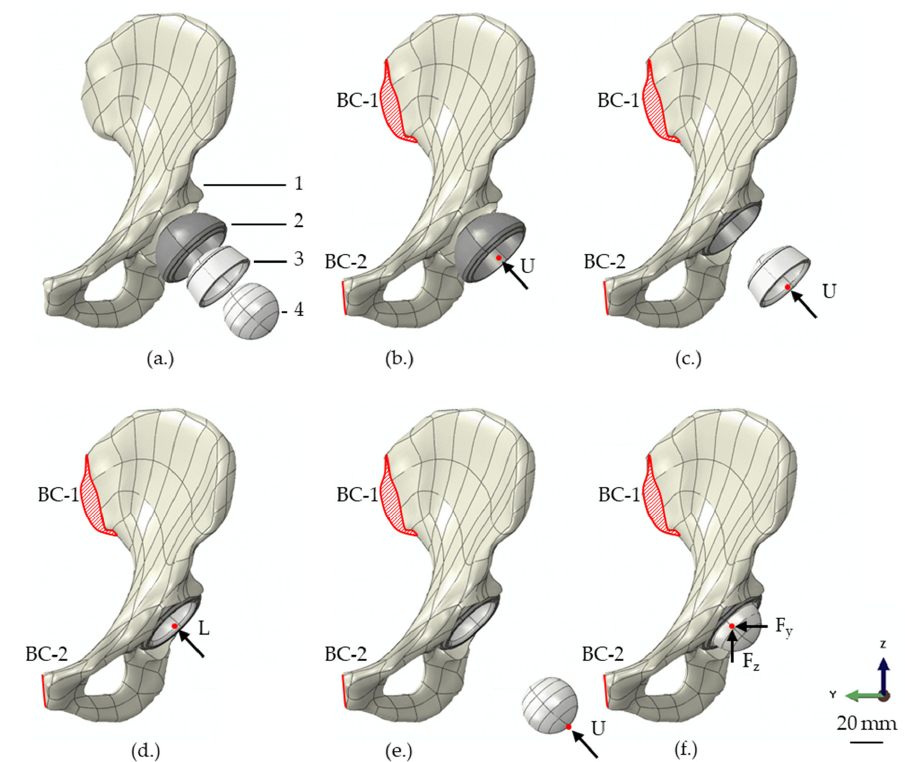
Figure 1. Depiction of the assembly ( a ) of the 3D finite element model consisting of a hemi-pelvis